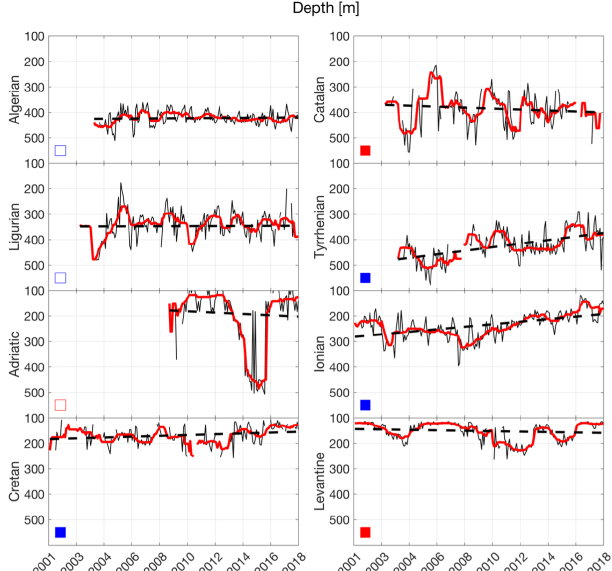
Figure 8. The same as Fig. 3 but for the LIW depth. Positive and negative trends (red and blue squares, respectively) in this case cor- respond to an increase and decrease of the depth (i.e. deeper or shal- lower),